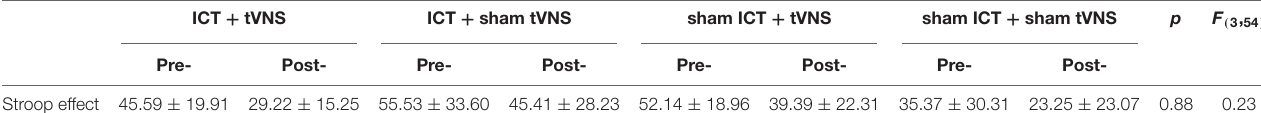
TABLE 3 | The mean of cwStroop in pre- and post-training tests (M ± SD). ICT + tVNS ICT + sham tVNS sham ICT + tVNS Pre- Post- Pre- Post- Pre- Post-